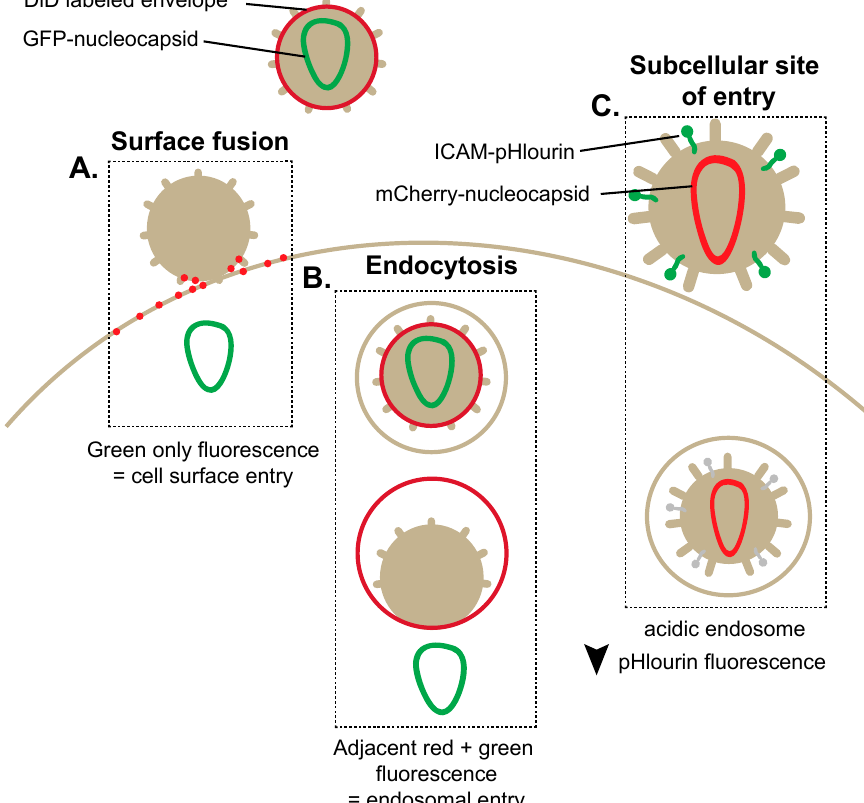
Figure 1. Fluorescent human immunodeficiency virus type 1 (HIV-1) vectors enable the visualization of alternative methods of HIV-1 cell-free entry. ( A ) Dialkylcarbocyanine analogue (DiD)-labeled HIV-1 expressing green fluorescent protein (GFP)-tagged nucleocapsid identifies viral fusion at the plasma membrane. Plasma membrane fusion corresponds to a loss of red fluorescence due to diffusion of the DiD probe in the plasma membrane and the subsequent presence of green fluorescence; ( B ) Endosomal entry of HIV-1 is marked by red and green puncta within the cell as DiD probe diffusion is limited to the smaller endosomal location. Viral entry through an endosome is detected by the visualization of a green signal (GFP-tagged nucleocapsid) migrating away from a red signal (DiD-labeled endosome); ( C ) pH-dependent HIV-1 entry can be measured by incorporation of an intracellular adhesion molecule 1 (ICAM)-pHlourin-labeled HIV-1. The decrease of pHlourin fluorescence corresponds to the presence of HIV-1 within the increasingly acidic endosomal